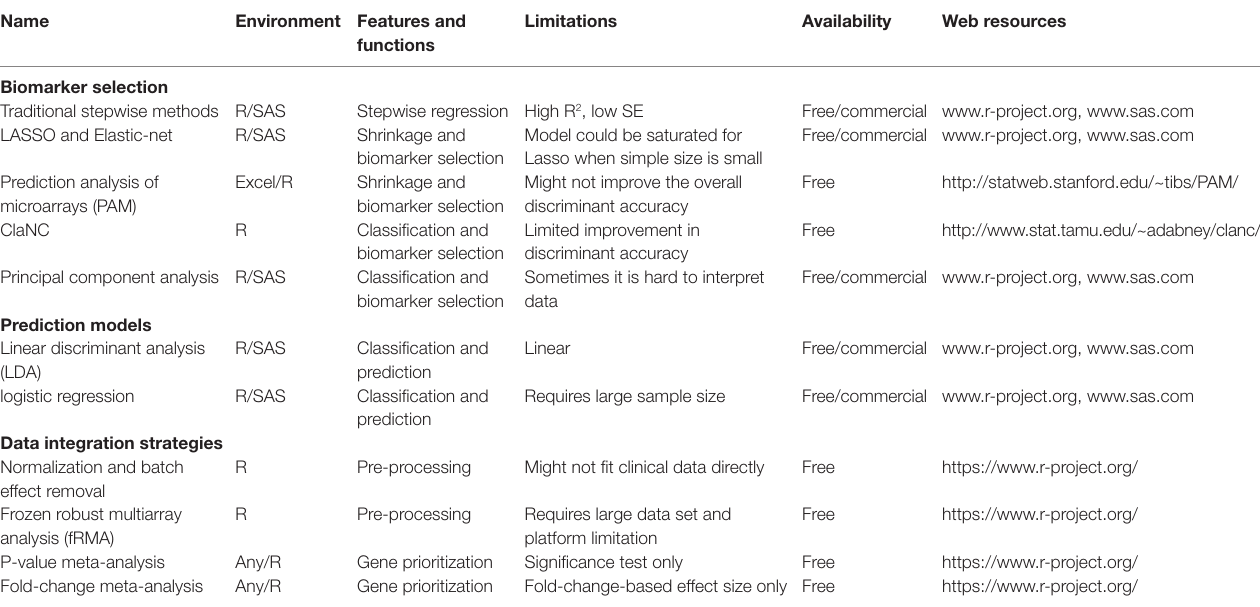
TABLe 1 | Primary computational algorithms for transplant biomarker discovery.